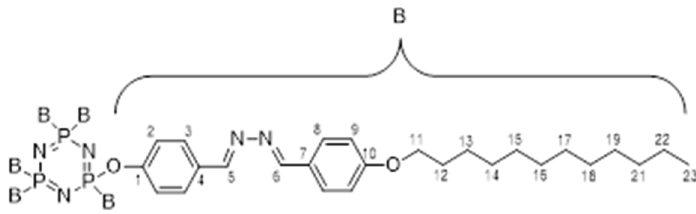
Figure 4. Structure of compound 4a with complete atomic numbering.